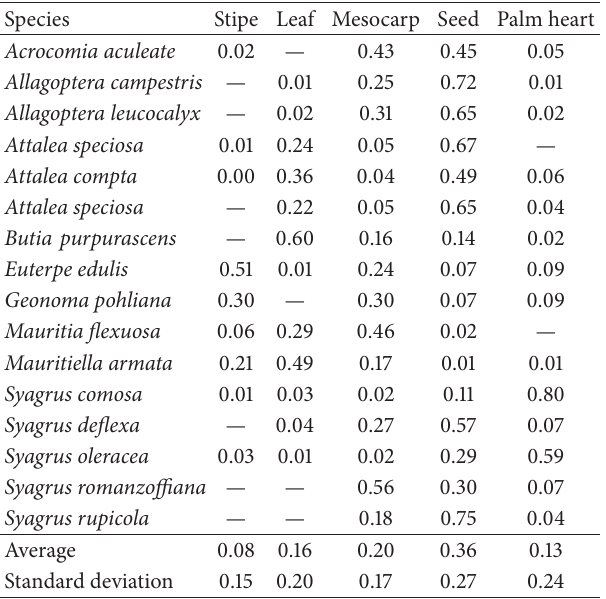
Table 8: Value of use index of the different parts (PPV) of palm speciesassignedbytheKalungacommunityEngenhoII,Cavalcante, GO, central western